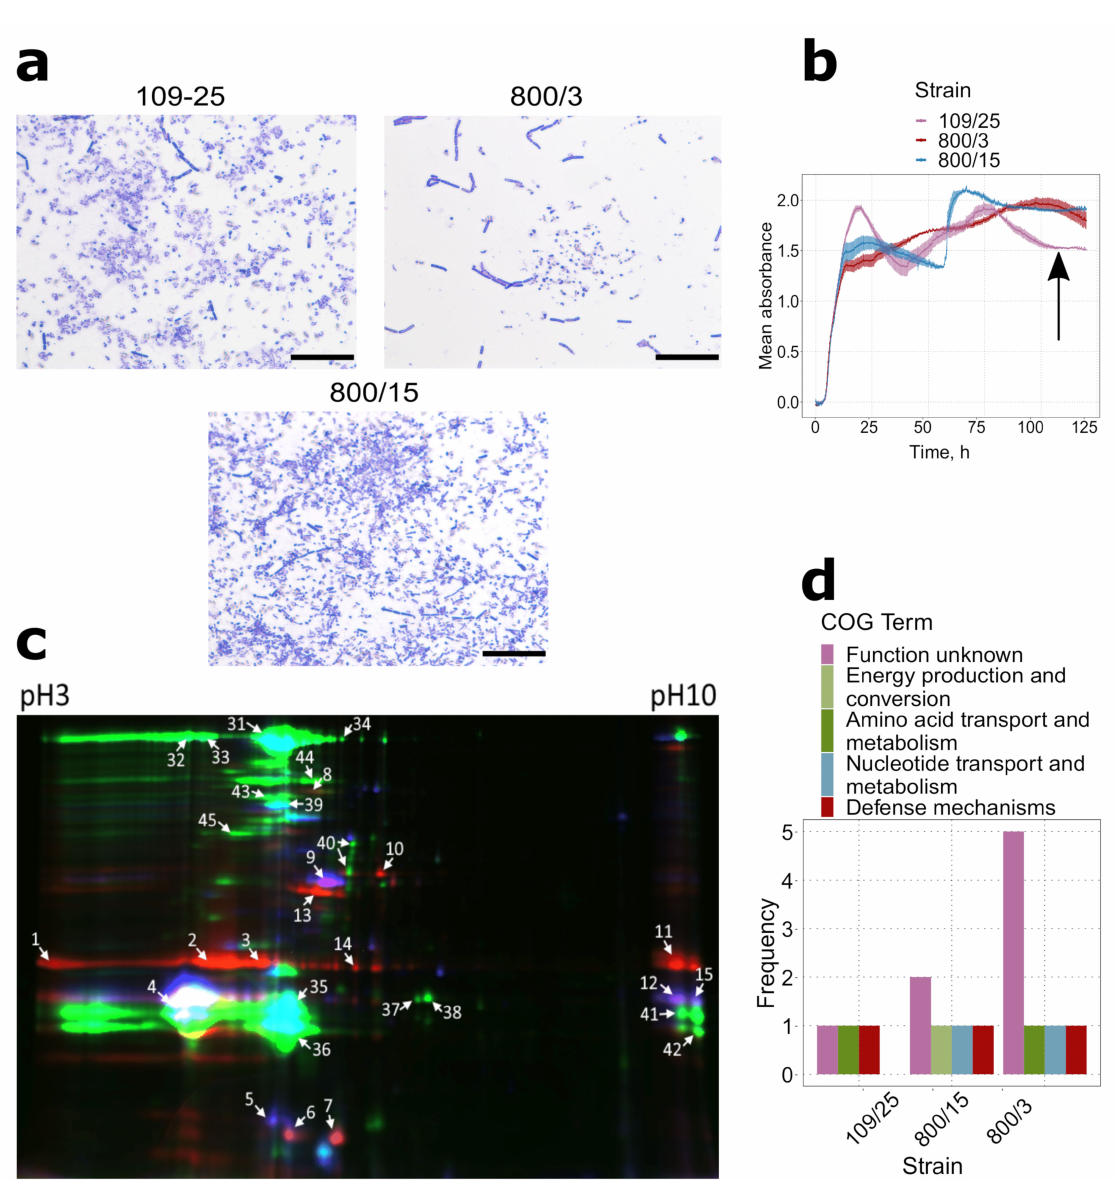
Figure 2. Proteomic signatures of Bt strains 109/25 (serovar darmstatdiensis ), 800/3 (serovar israelensis ), and 800/15 (serovar thuringiensis ) ( a ) Microscope images of strain 109/25, strain 800/3, and strain 800/15 sporulating cultures All photos were taken at × 1000 magnitude in transmitted light. Scale bars are given as black rectangles and denote 20 µ m. Parasporal inclusions were stained with Coomassie Blue. ( b ) Growth curves of strains’ 109/25, 800/15, and 800/3 cultures grown on T3 medium. The growth curve for strain 800/3 sporulating culture is the same as in Figure 1d. The black arrow marks the time of the spore culture’s protein extraction ( c ) 2D-DIGE image corresponding to the overlapping Cy2, Cy3, and Cy5 fluorochrome channels of Bt serovars spore proteomes. Red light channel indicates- proteins from strain 800/3, blue—strain 109/25 proteins, and green—800/15 proteins. ( d ) The COG term distribution among the proteins detected with ESI-MS. COG annotation was assigned to the reference sequences by sequence homology using eggNOG